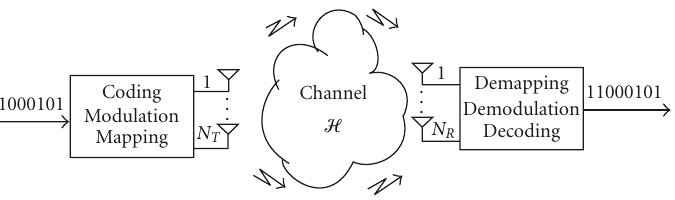
Figure 1: Principle of MIMO techniques. Remark that H plays a quite similar role of the quantum scattering theory S -matrix of particle